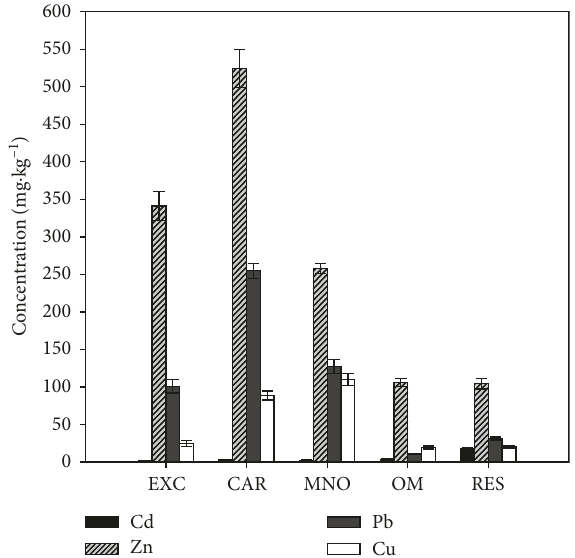
Figure 2: The sequential fractionations of heavy metals in con- taminated